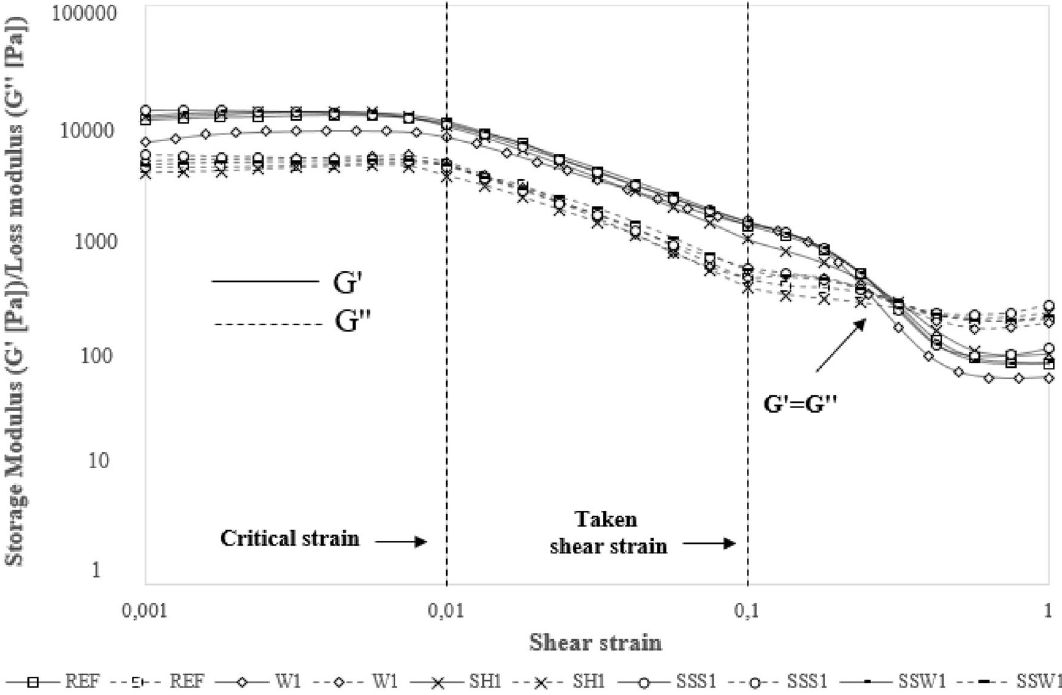
Fig. 1 Storage modulus/loss modulus vs shear strain for REF, W1, SH1, SSS1 and